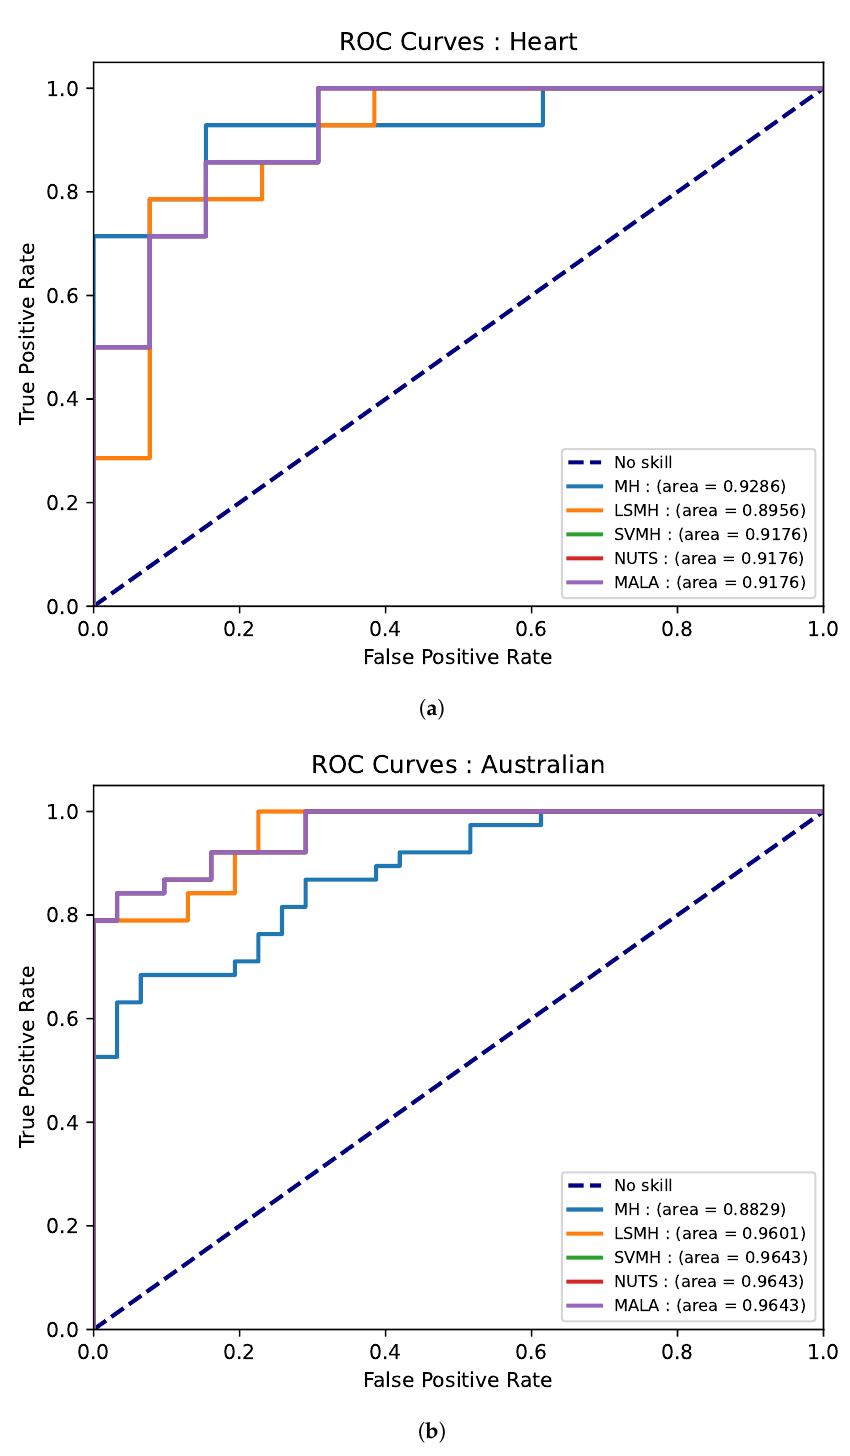
Figure 4. Predictive performance for all the sampling methods on the real world classification datasets. The results were averaged over thirty runs of each algorithm. ( a ) ROC curves for the Heart dataset and ( b ) ROC curves for Australian credit